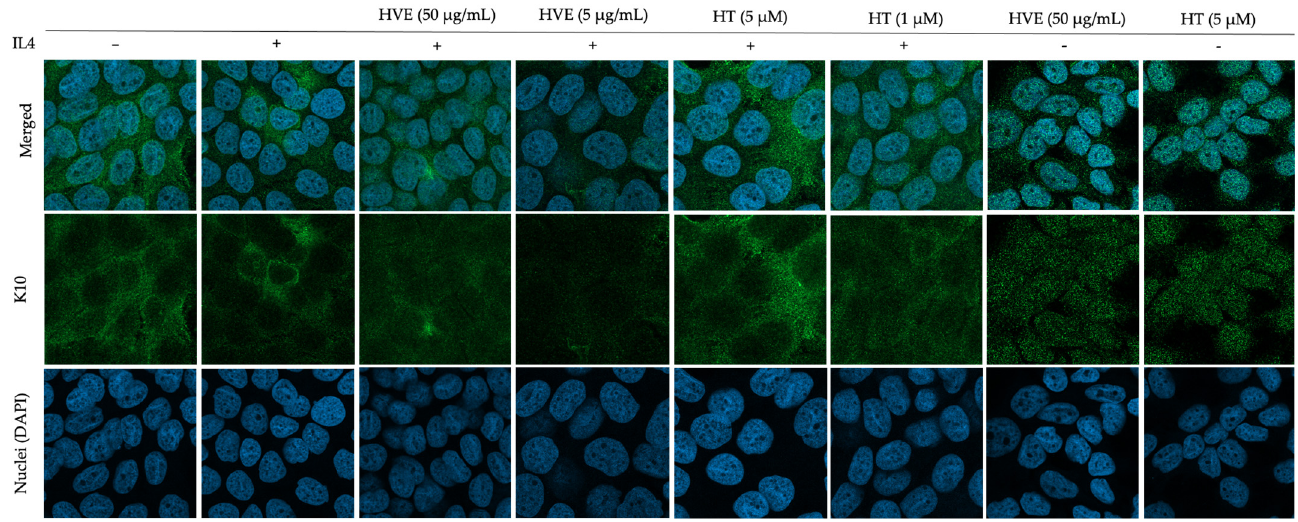
Figure 6. Immunofluorescence images reporting the effect of HVE and HT treatment (24 h) on the impairment of K10 expression induced by IL-4 (100 ng/mL) in differentiated HaCaT cells. HVE, Hamamelis virginiana bark extract; HT, hamamelitannin. Green, K10 staining; blue, DAPI (nuclei) staining.